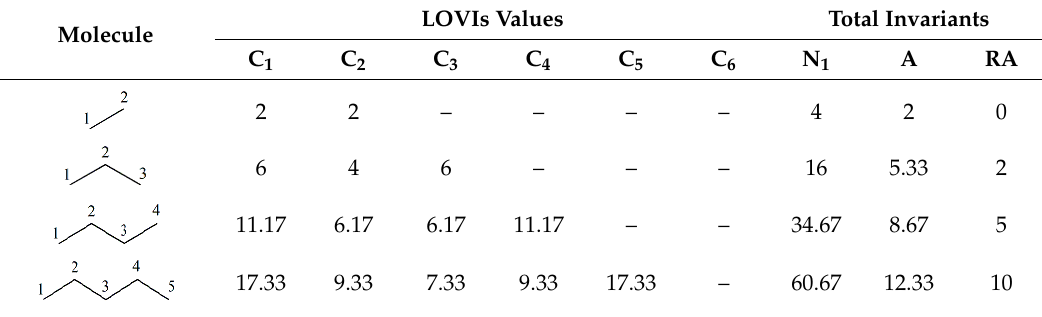
Table 2. Codification of the chain size, multiple bonds and their positions in the molecule.